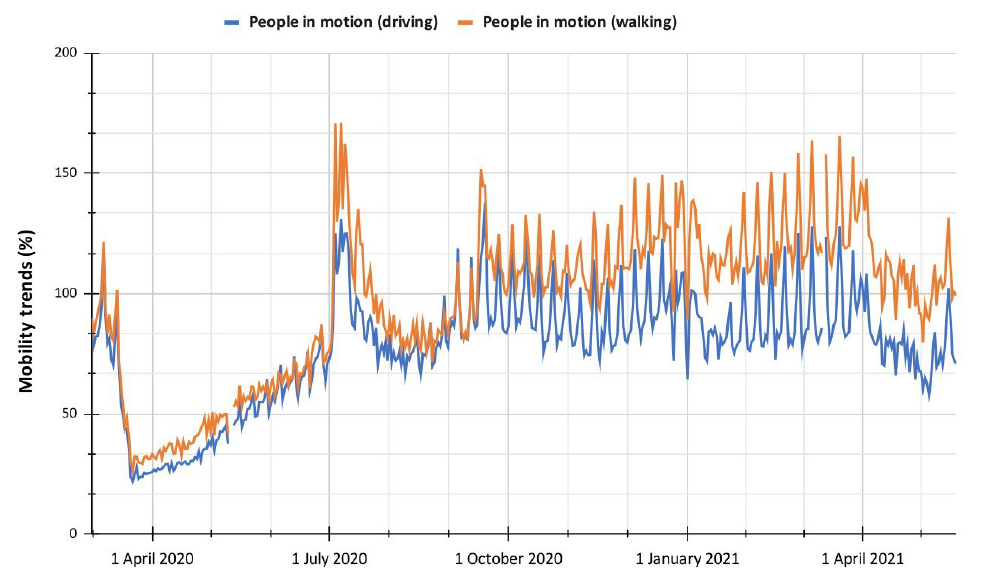
Figure 10. Mobility trends reported by Apple for 1 March 2020, to 19 May